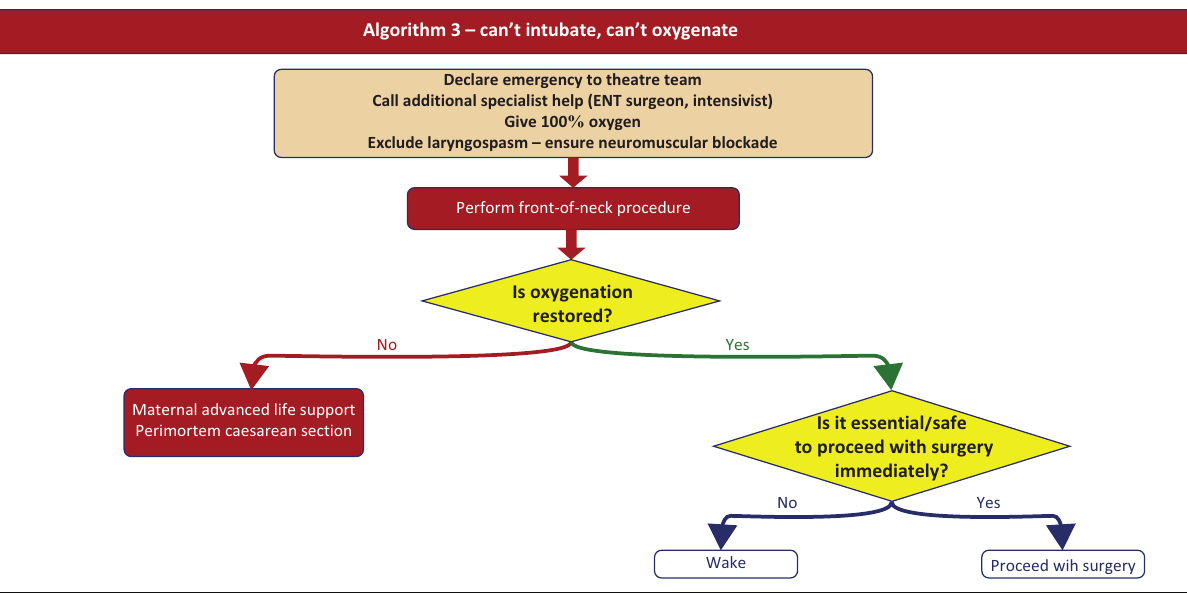
FIGURE 4: ‘Can’t intubate, can’t oxygenate’.